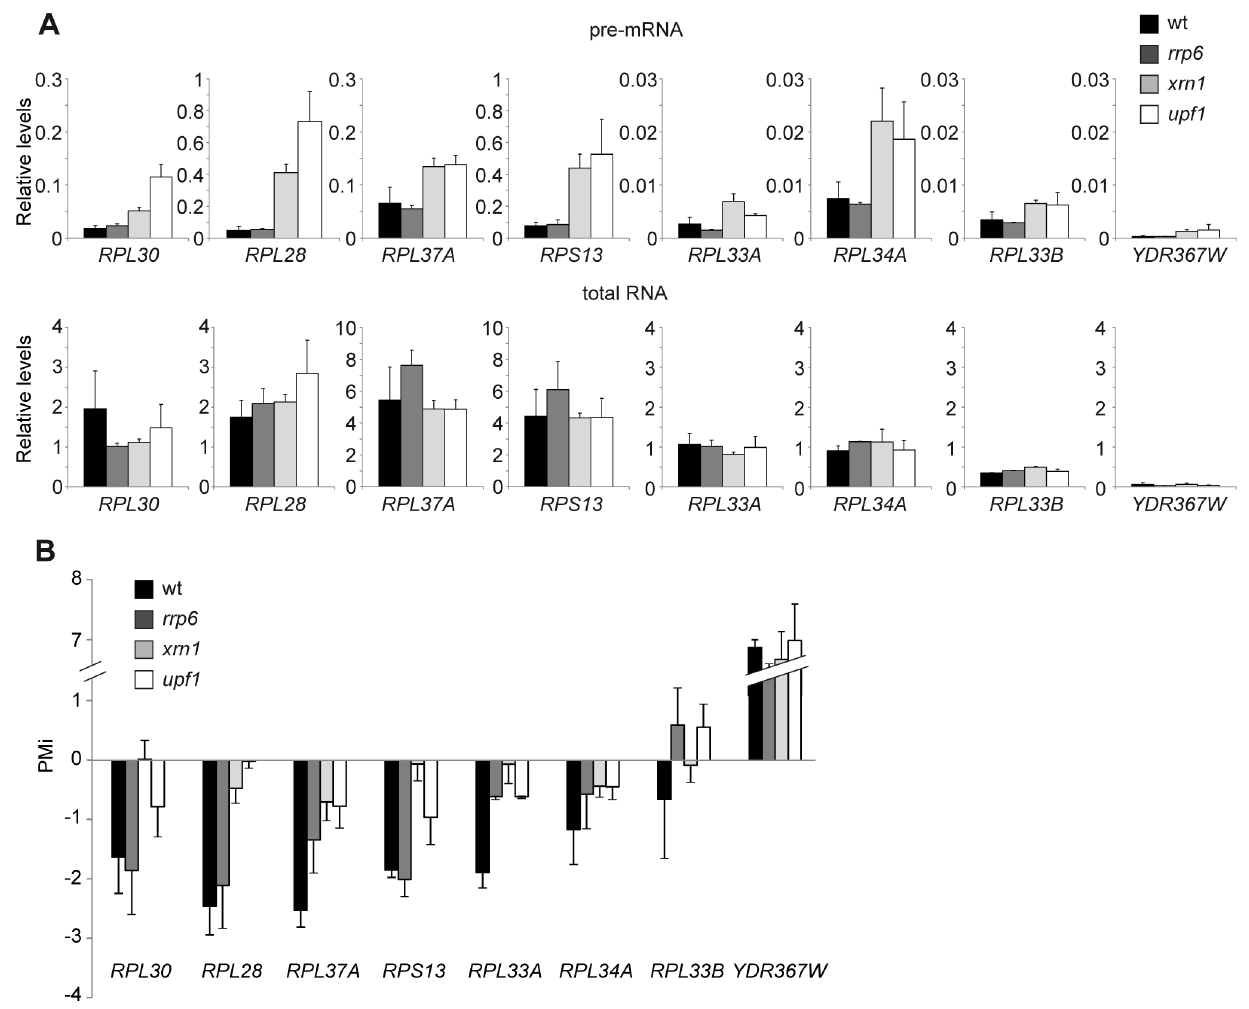
Figure 4. Upf1 and exonuclease Xrn1 contribute to the decrease in ribosomal protein pre-mRNA during osmotic stress. (A) The total and pre-mRNA relative levels are shown for the non-stressed cells of a wild-type strain and strains with deletions in RRP6 , XRN1 or UPF1. (B) Representation of PMi in the cells treated with 0.4 M NaCl for 15 minutes in relation to untreated cells for the wild-type strain and the same mutant strains as in (A). The intron and exon levels of the transcripts RPL30 , RPL28 , RPL37A , RPS13 , RPL33A , RPL34A, RPL33B and YDR367W were examined by quantitative RT-PCR using specific primers to those regions. Data and errors bars represent the average and standard deviation of 3 independent experiments.